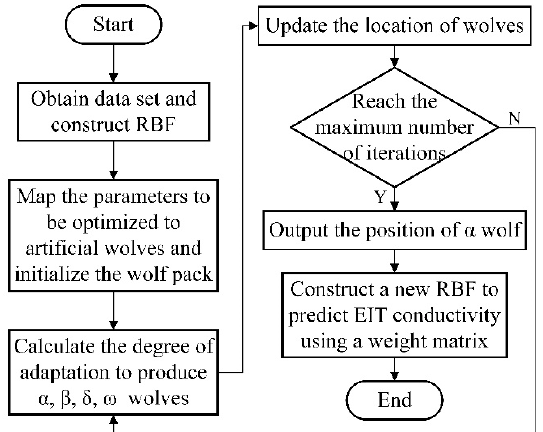
Figure 4. Flowchart of the EIT algorithm based on the proposed GWO-RBFNN. Using the optimized algorithm to calculate the internal conductivity of the EIT results in a reconstructed image.